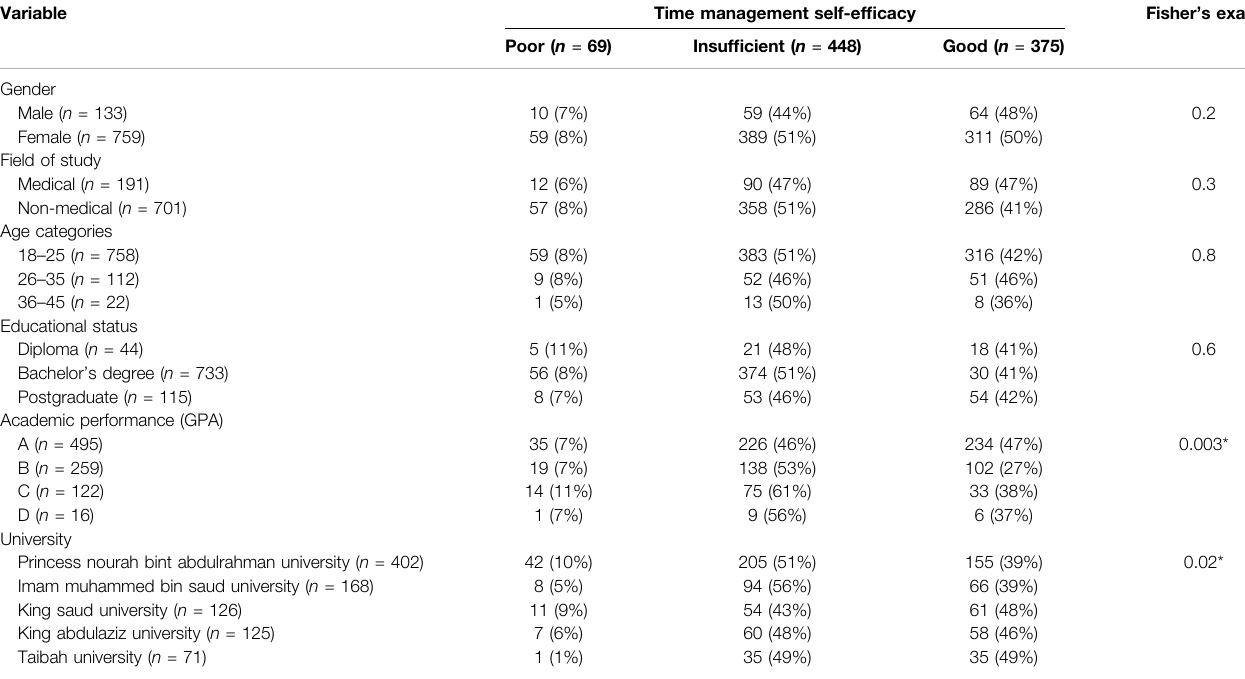
TABLE 4 | Level of self-ef fi cacy in the time management domain by student characteristics.